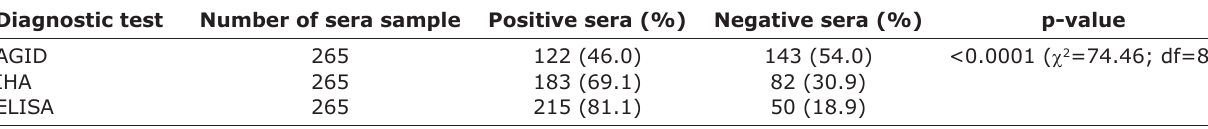
Table-1: Comparison of AGPT, IHT, and ELISA results for detection of infectious bursal disease in local chickens and guinea fowls. Diagnostic